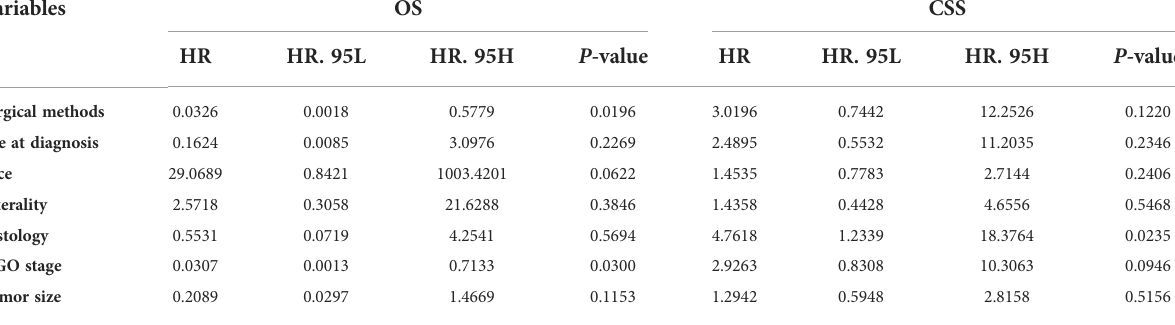
TABLE 2 Independent risk factors affecting OS and CSS analyzed by Cox proportional hazards model. Variables